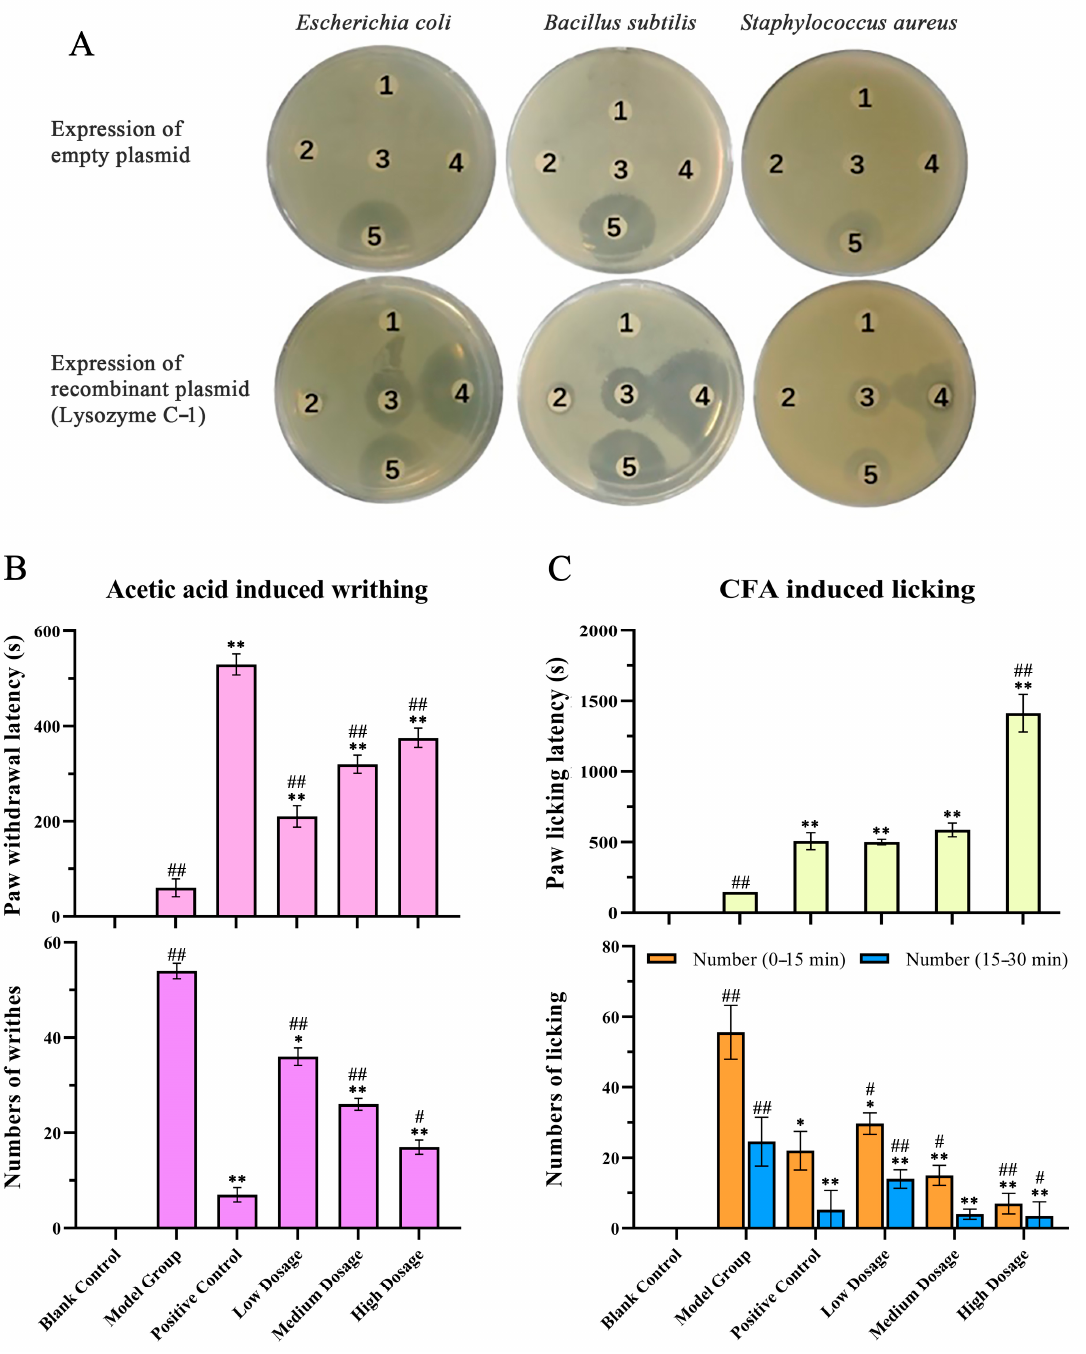
Figure 6. Activity validation of antimicrobial, anti − inflammatory, and analgesic components. ( A ) antimicrobial activity of a fusion protein solution containing lysozyme. (Note: 1: phosphate − buff- ered saline (PBS) group; 2: protein concentration 0.01 µg/µL; 3: protein concentration 0.1 µg/µL; 4: protein concentration 1 µg/µL; 5: antibiotic group 0.5µg/ µL.). ( B , C ) Anti − inflammatory and anal- gesic activity of the NPB polypeptide. ( B ) Acetic acid − induced writhing latency and duration over 15 min in mice. ( C ) Complete Freund’s adjuvant (CFA) − induced paw licking latency and amount of